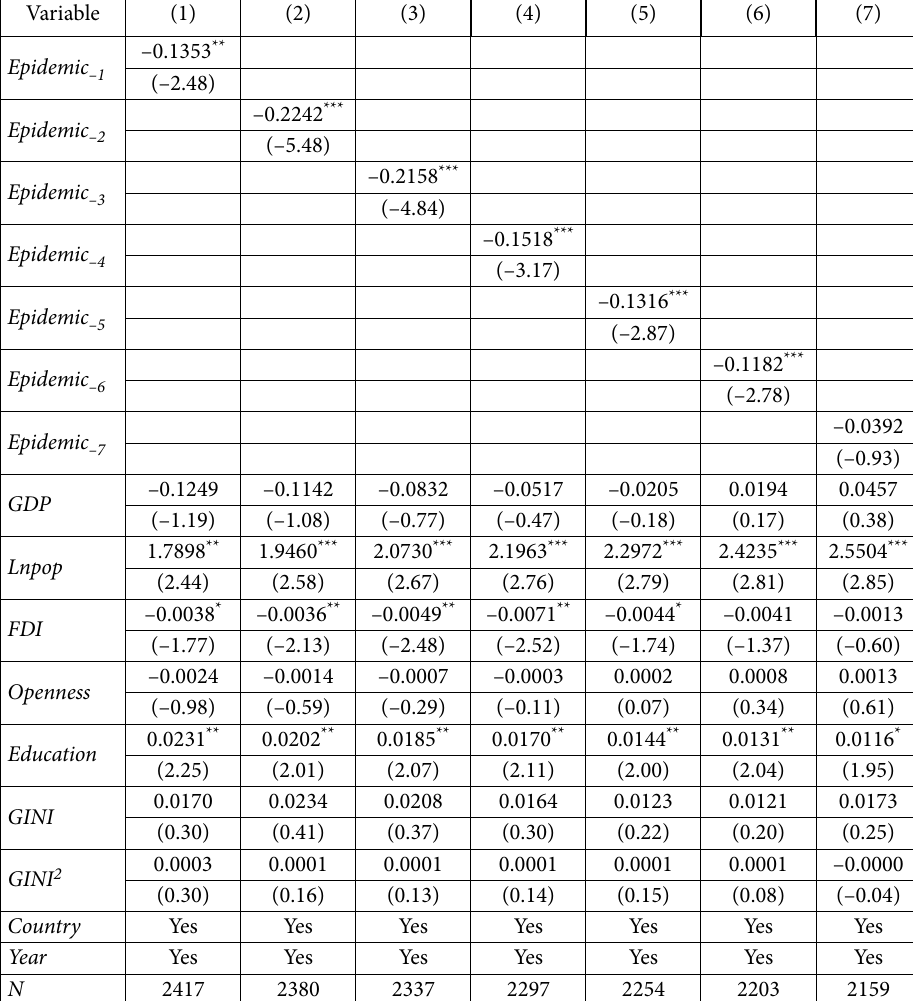
Table 3. Estimation results of a time lag effect of 1–7